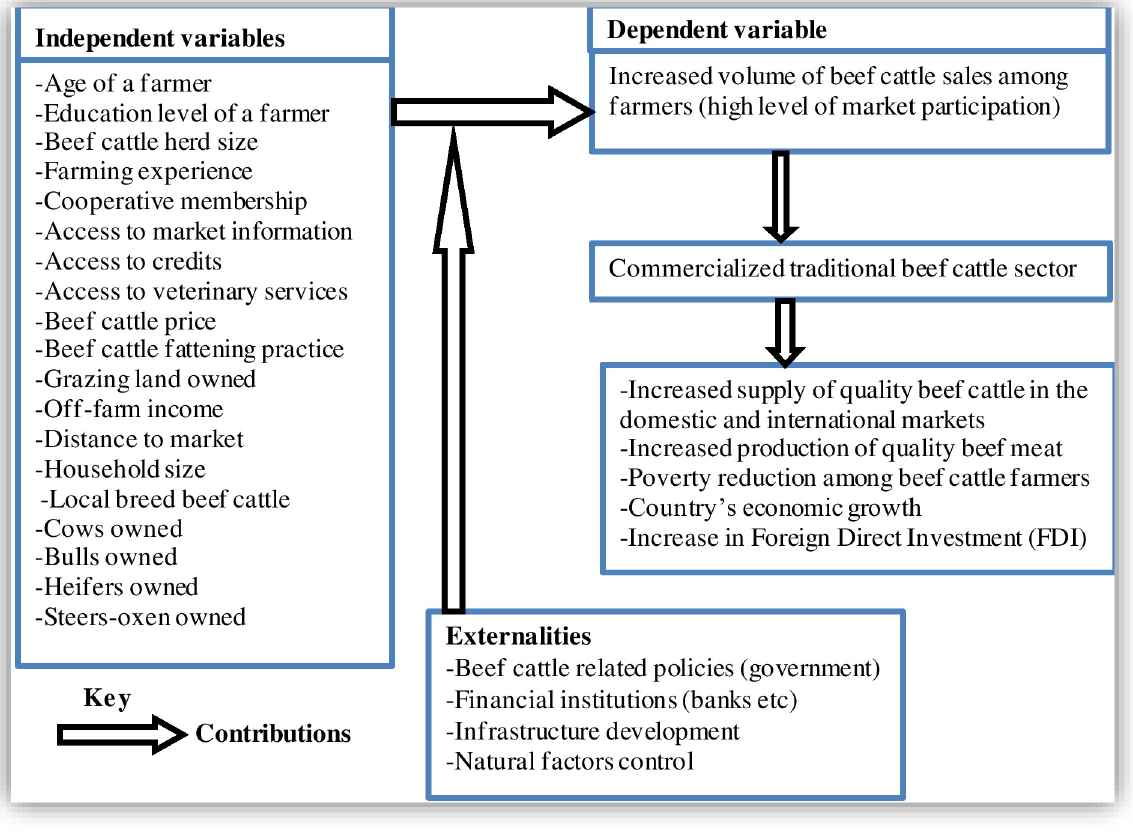
Fig 1. Conceptual